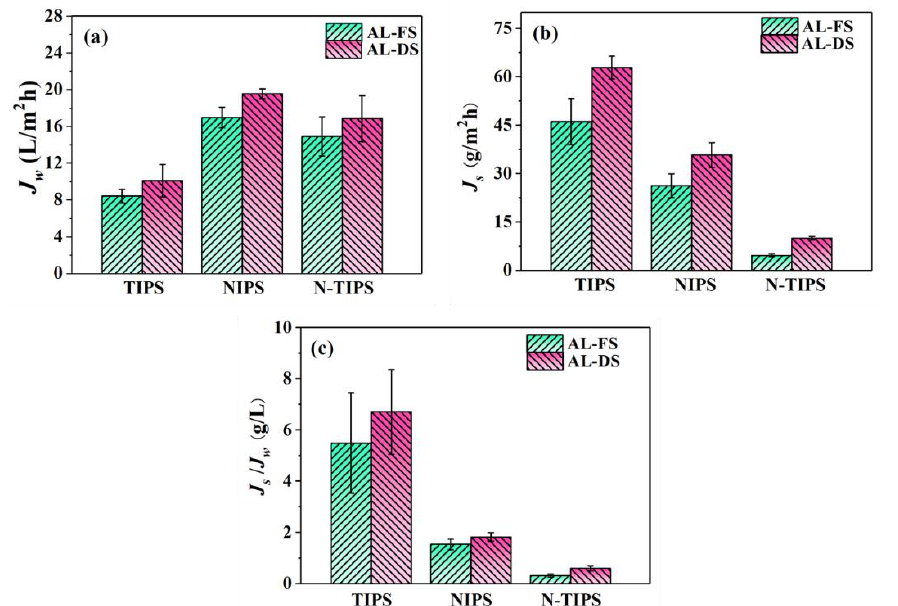
Figure 8. ( a ) Water flux; ( b ) reverse salt flux; and ( c ) specific salt flux of TFC-FO membranes at AL-DS and AL-FS modes. The draw solution and feed solution are 1.0 M NaCl and DI water, respectively. The cross-flow velocity is 20 L/h. Table 3. The intrinsic transport parameters of TFC-FO